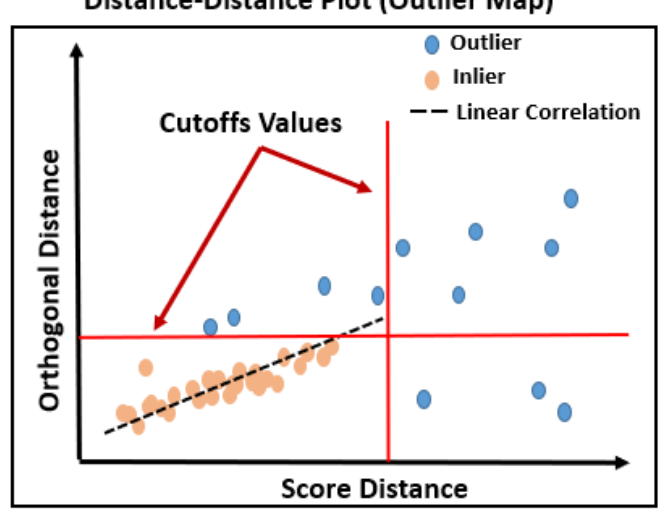
Figure 4. Shows how the outliers are detected using the PCA